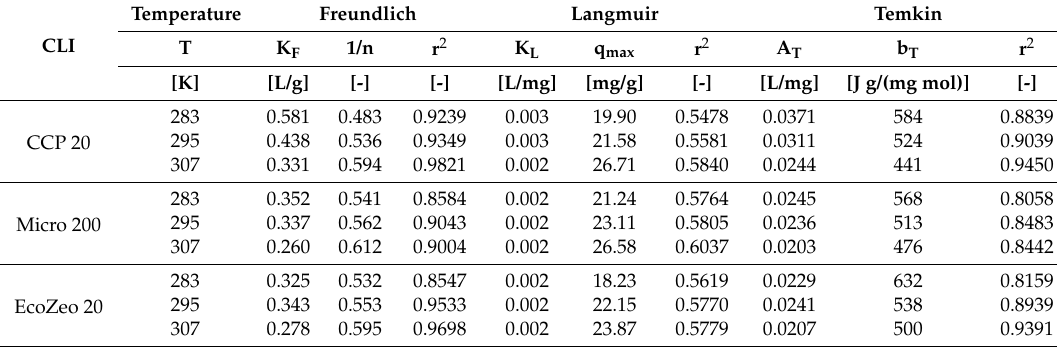
Table 6. Coefficients of the isothermal adaptation according to Freundlich of CCP 20, Micro 200,